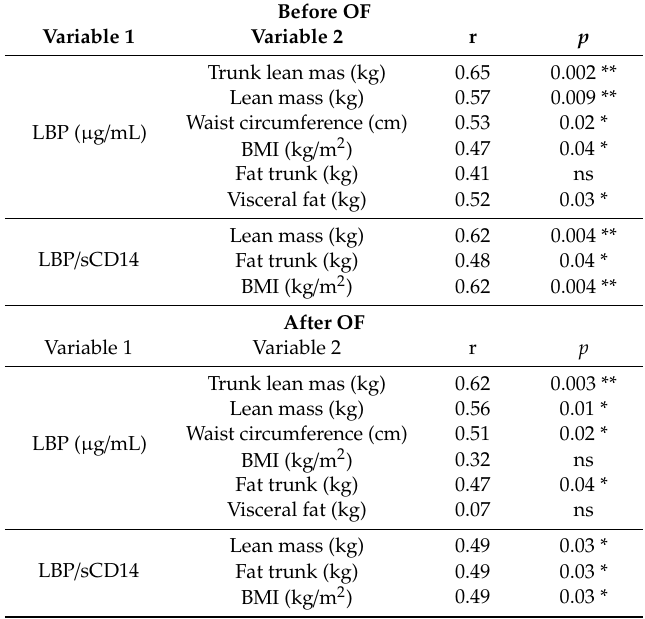
Table 3. Correlation analyses (Spearman) of fasting LBP and LBP / sCD14 with mass parameters in the overfeeding clinical trial ( n = 18 men). * p < 0.05; ** p <